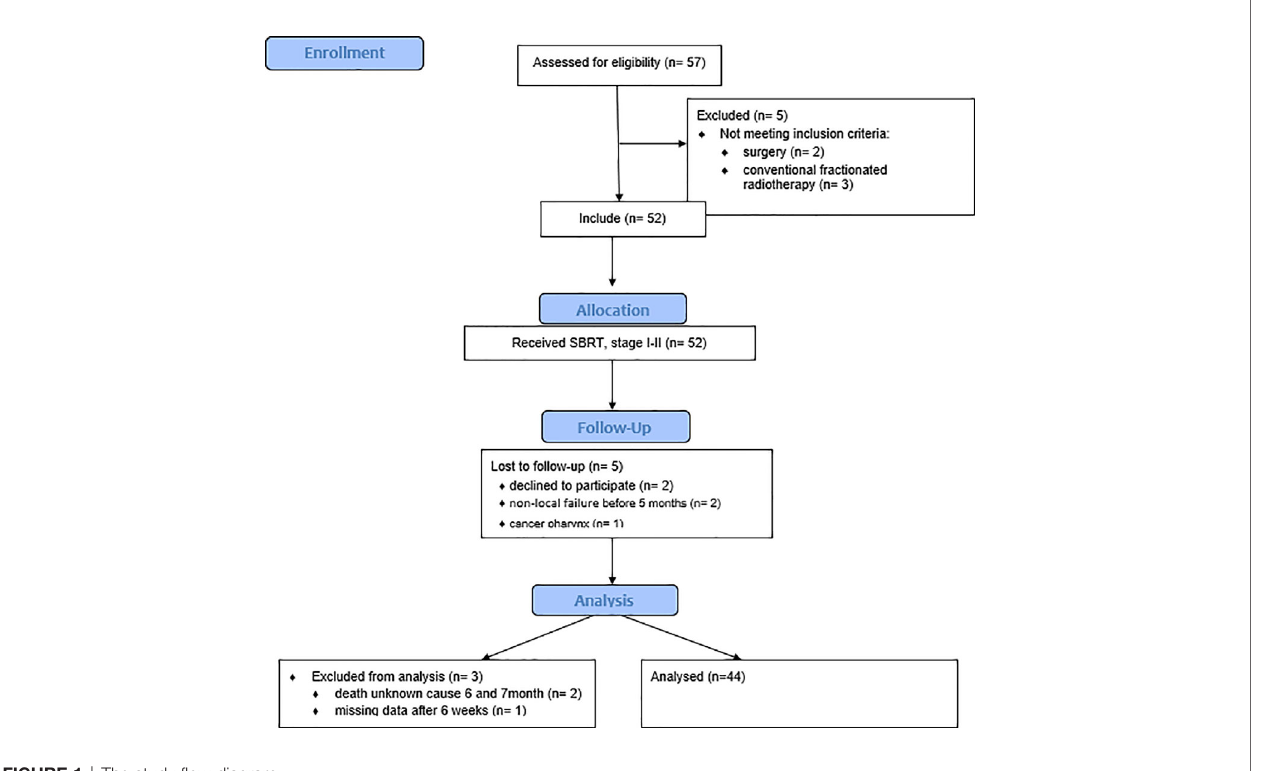
FIGURE 1 | The study fl ow diagram.